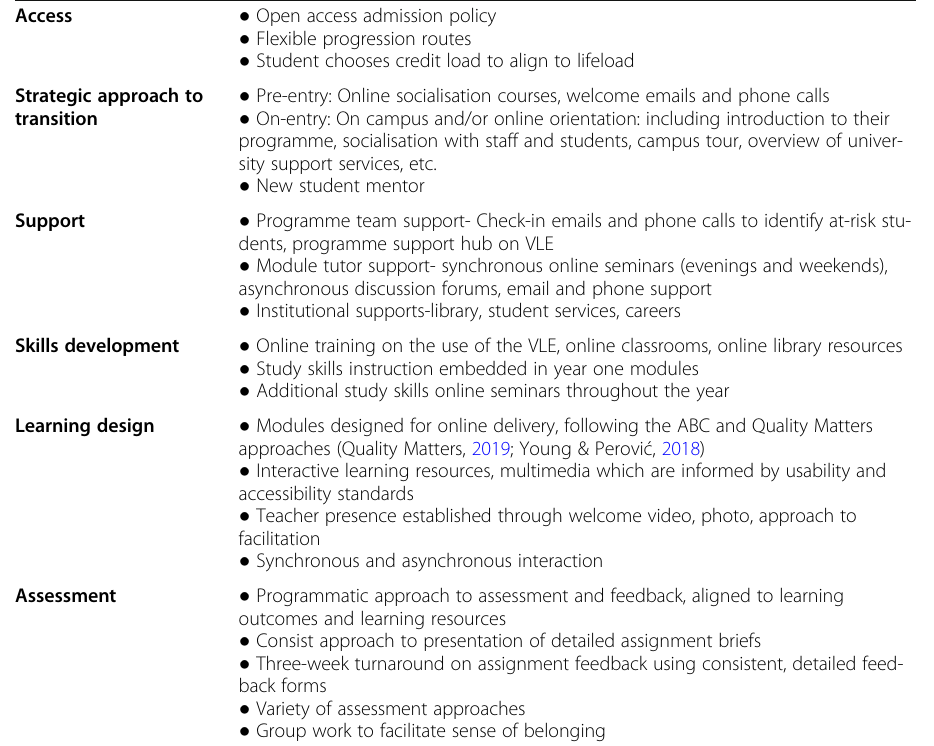
Table 1 Our approach to online student engagement